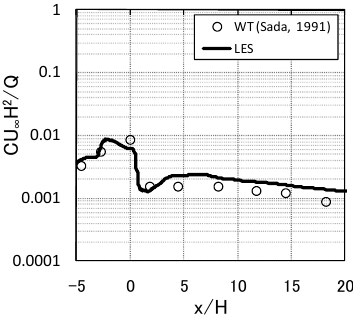
Fig. 6. Streamwise variations of mean concentration near the ground level. Figure 6. Streamwise variations of mean concentration near the